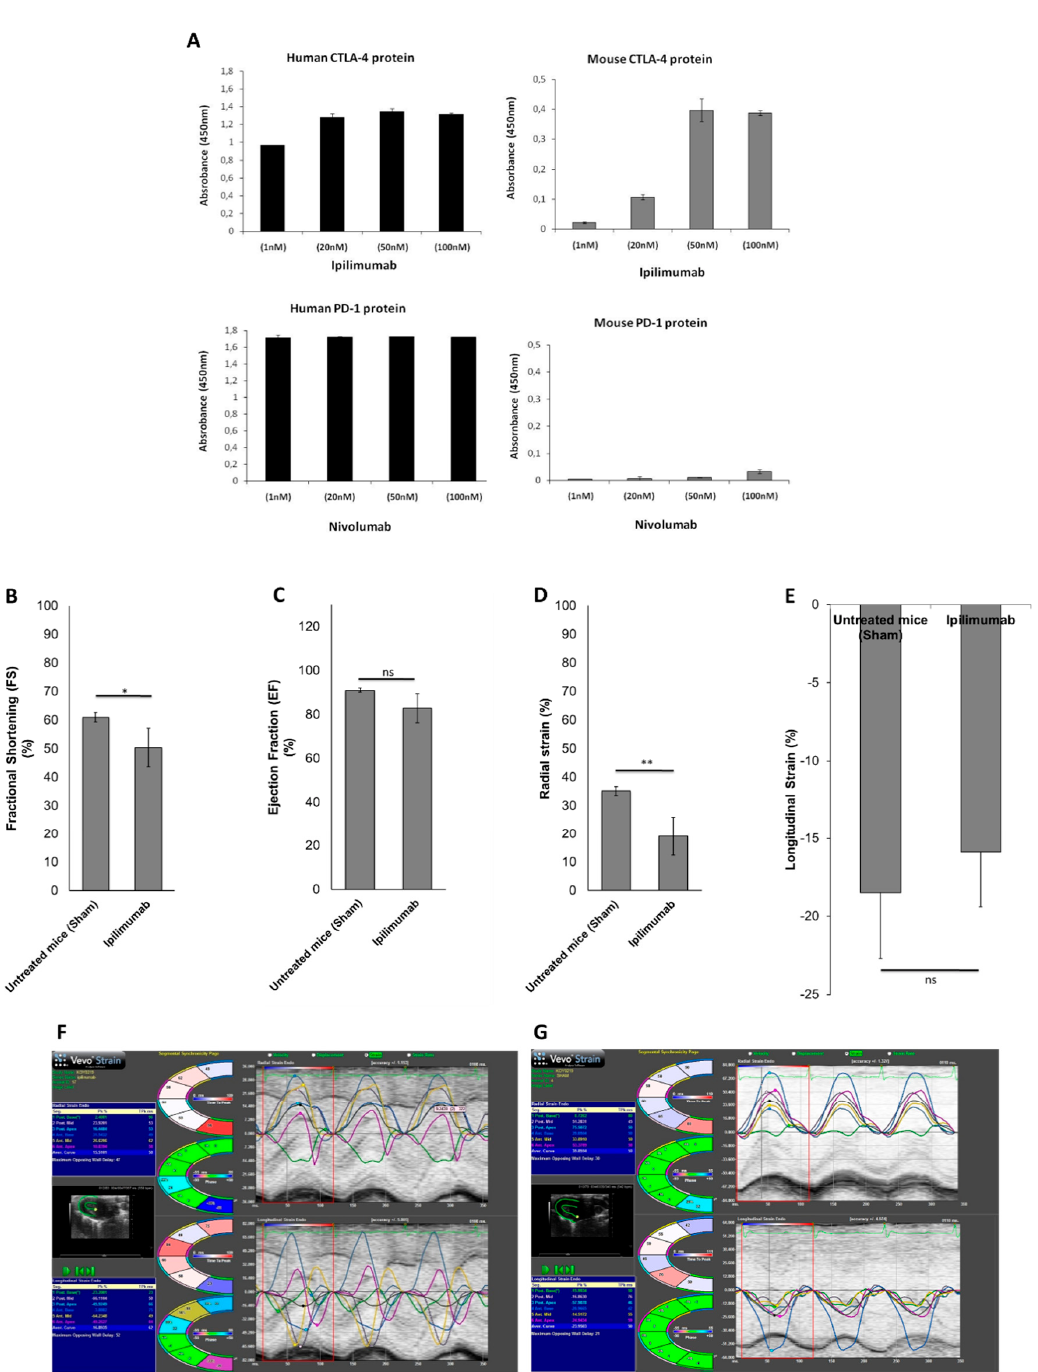
Figure 4. ( A ) Binding assays of Nivolumab and Ipilimumab on mouse or human purified recombinant proteins; ELISA assays of the indicated antibodies used at increasing concentrations on purified human (black bars) or mouse (grey bars) PD-1 or CTLA-4 proteins. graphic of fractional shortening (FS) ( B ) ejection fraction (EF), ( C ) radial strain ( D ), and longitudinal strain ( E ) in mice untreated (sham) or treated with Ipilimumab. Images of strain in untreated ( F ) or Ipilimumab-treated ( G ) mice. Error bars depict means ± SD. ** p < 0.01; * p < 0.05. ; ns: not significant.